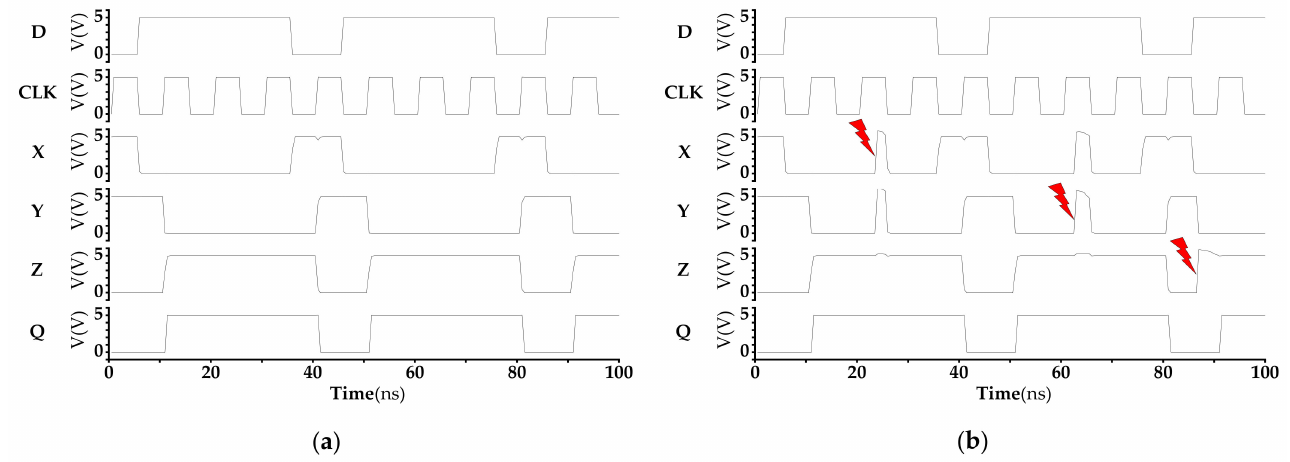
Figure 9. DM-DFF: ( a ) simulation waveform of DM-DFF without SETs; ( b ) simulation waveform of DM-DFF with